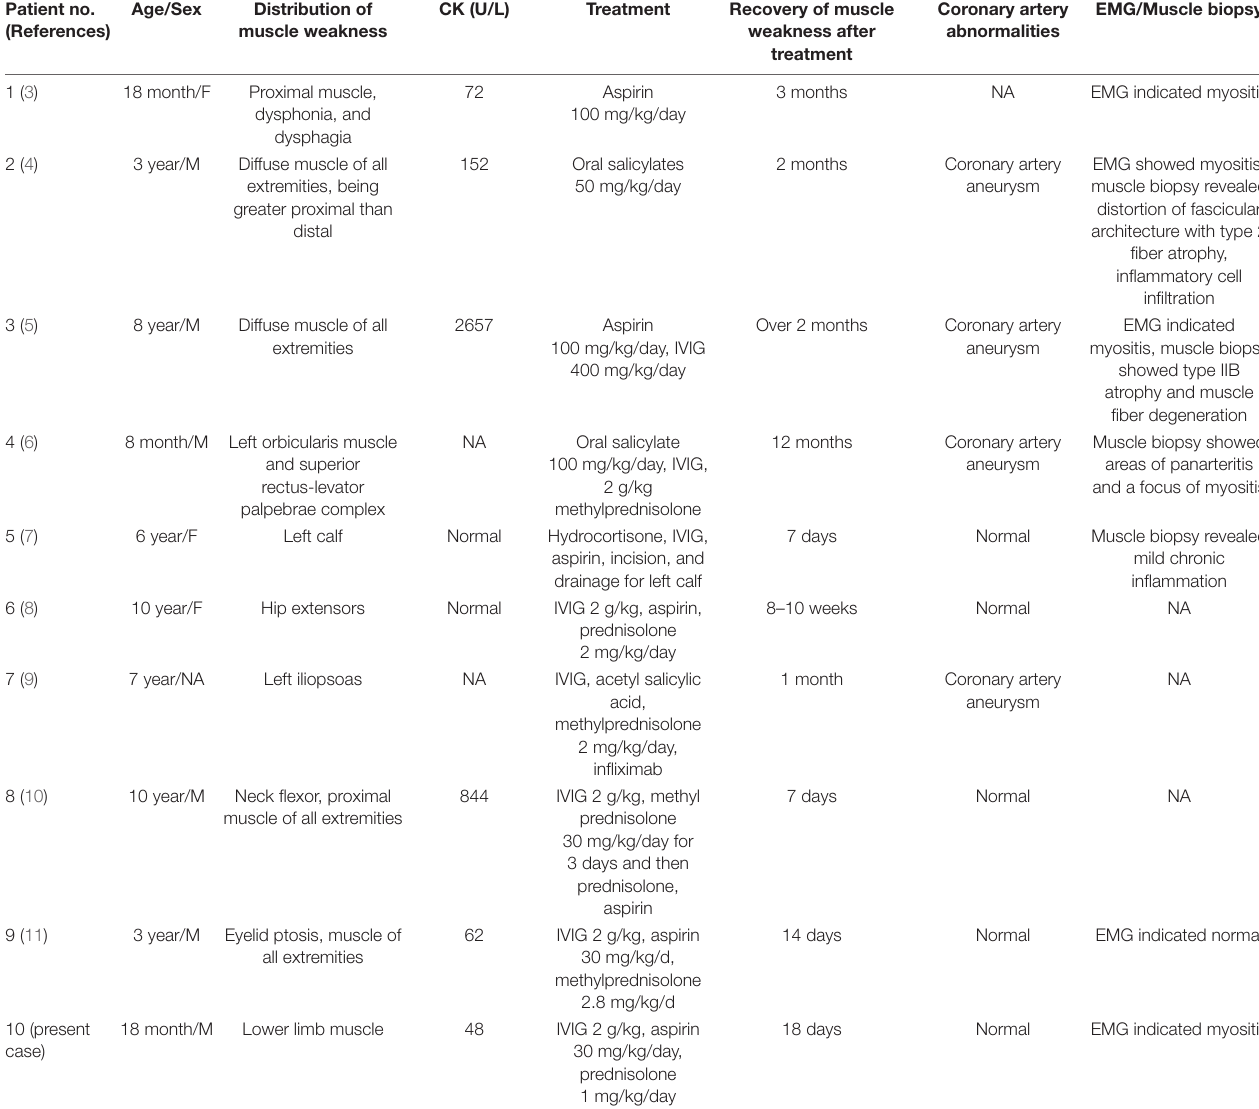
TABLE 2 | Review of previously reported cases with Kawasaki disease and